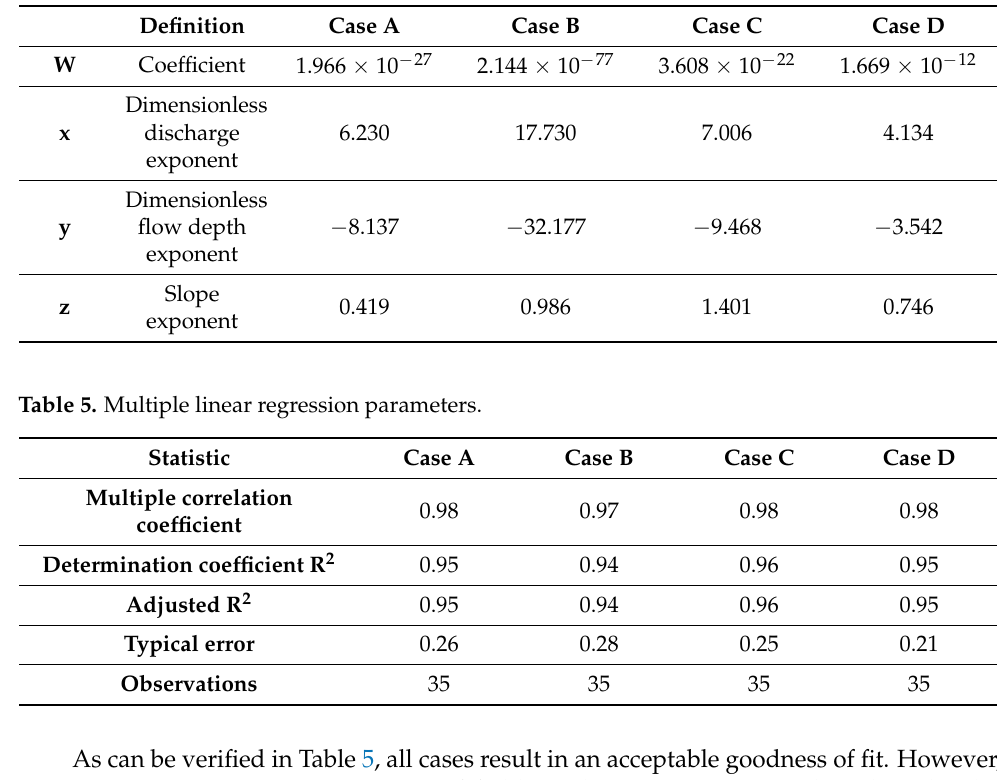
Table 4. Equation (7) parameters for each simulation case.